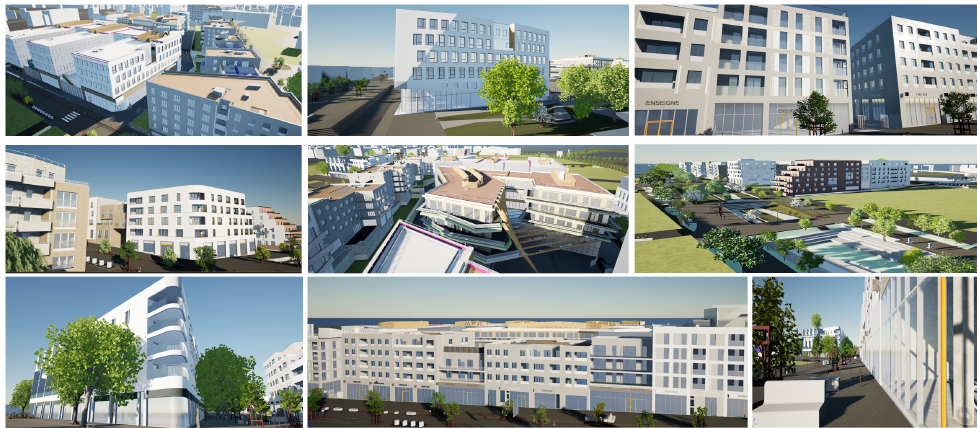
Figure 20. Gallery of points of view of the final immersive visit: many various architectural environ- ments are